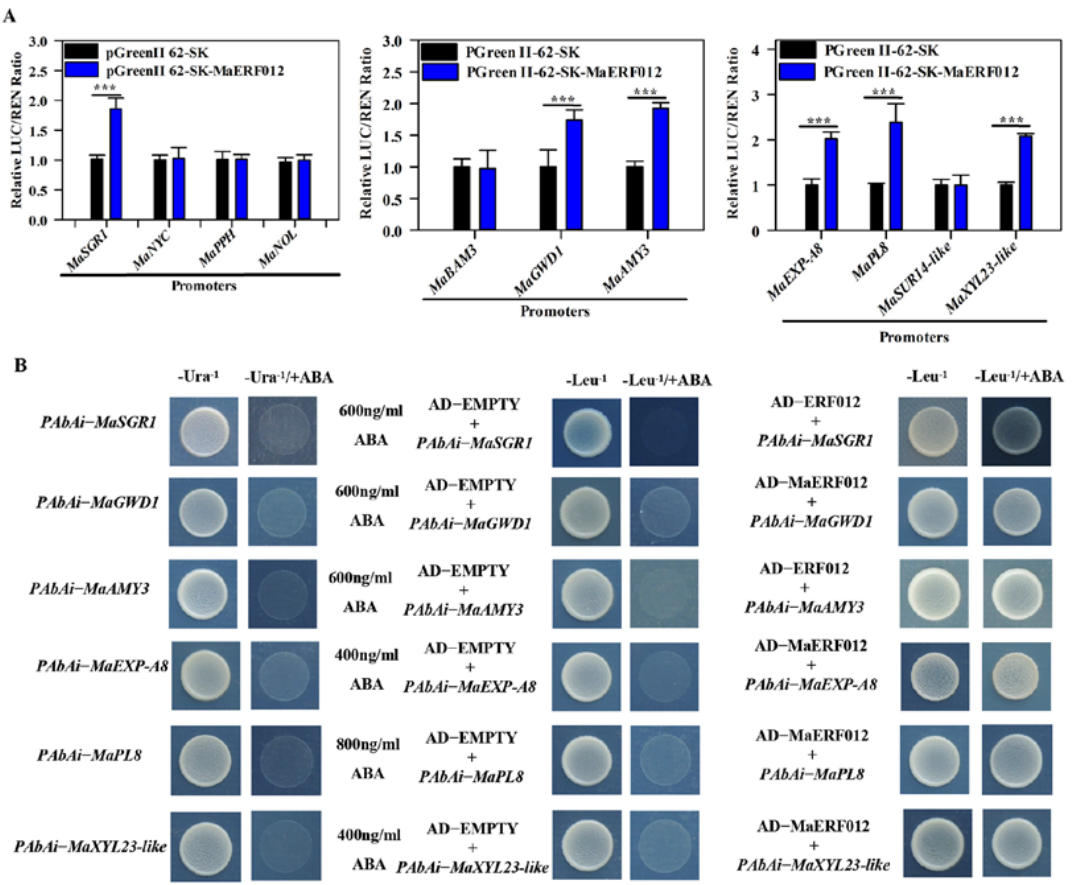
Figure 3. MaERF012 activates the promoter activity of Chl, starch, and cell wall degradation-related genes. ( A ) DLR was used to assay the LUC activity of four Chl degradation, three starch degradation, and four cell wall degradation genes regulated by MaERF012. An empty vector was used as a reference control (set as 1). *** indicates significantly different at p < 0.001 level. ( B ) Y1H was used to assay the interaction between MaERF012 and the promoter of MaSGR1 , MaGWD1 , MaAMY3 , MaEXP-A8 , MaPL8 , and MaXYL23-like .